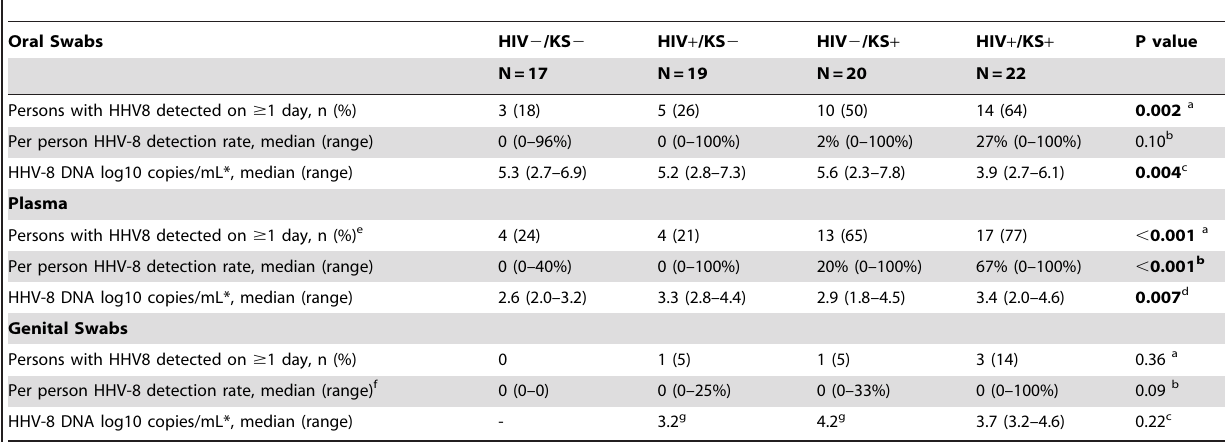
Table 2. Frequency and Quantity of HHV-8 Detection among Participants with and without HIV and KS.